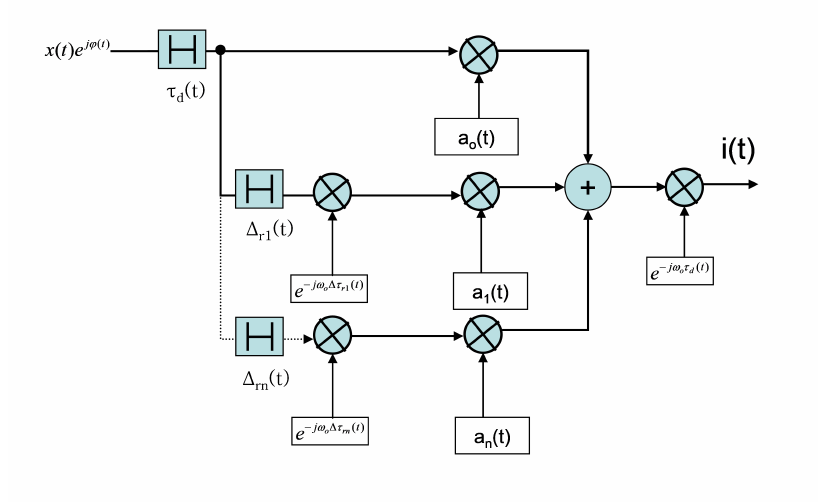
Figure 2. Representation of the multipath signal in the complex envelope domain.